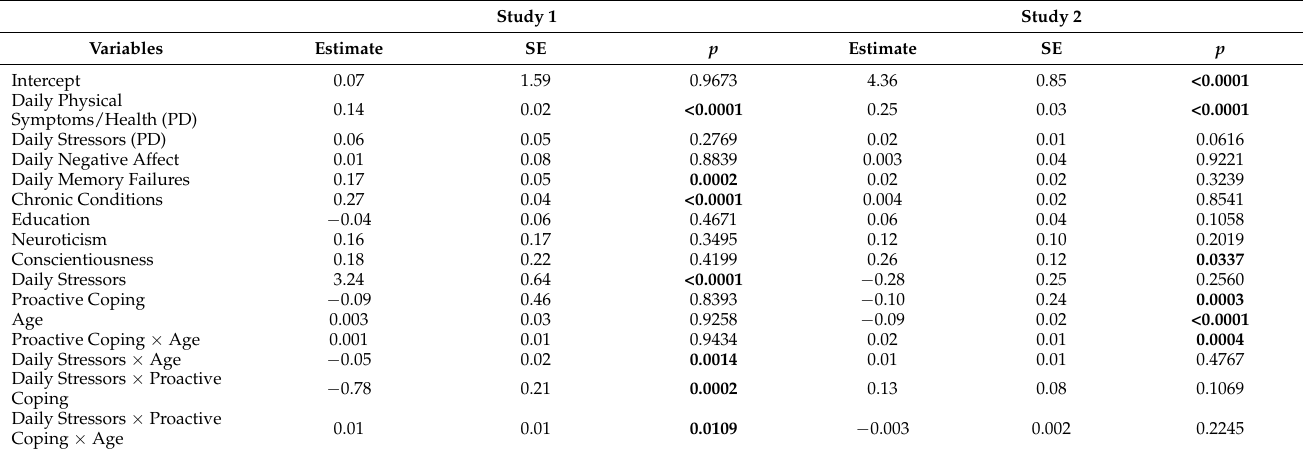
Table 3. Full Sample Models.